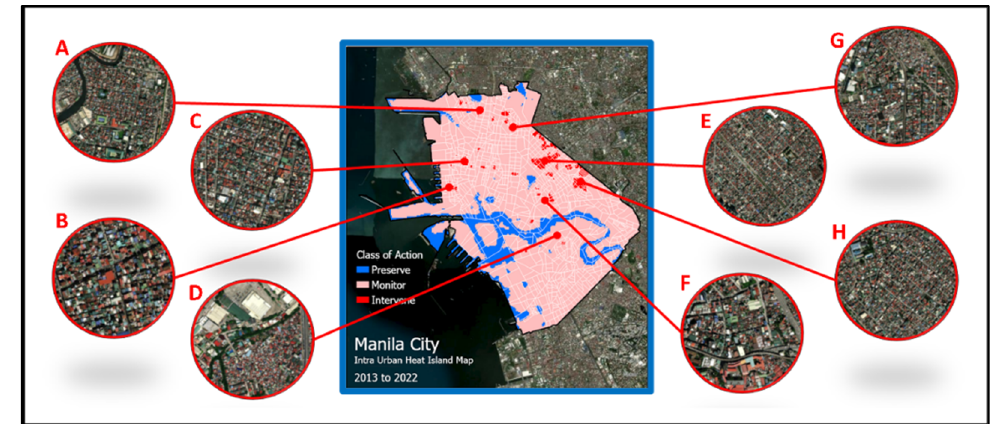
Figure 14. Some areas with the “Intervene” Class of Action. ( A – H ) are the areas highlighted to show their morphologies.